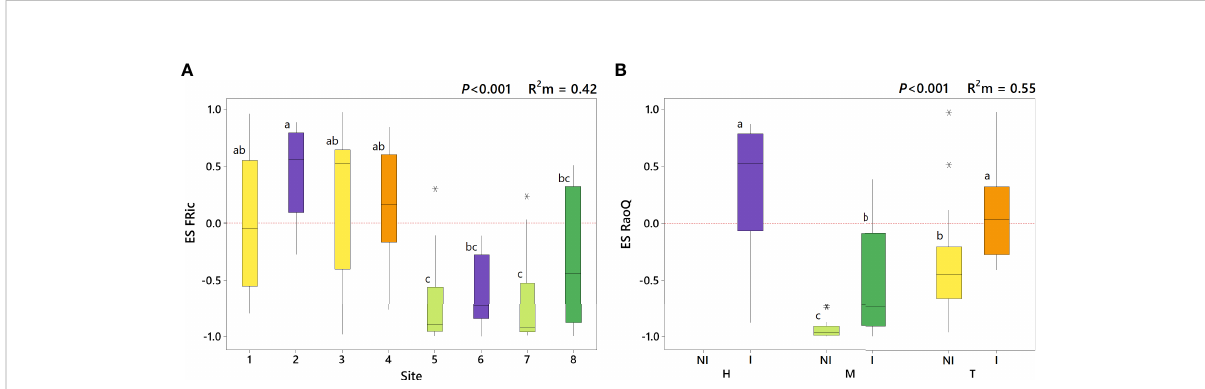
FIGURE 2 Effect size of FRic (ES FRic) depending on site (A) and effect size of RaoQ (ES RaoQ) depending on the interaction of weed management and irrigation (WM:I) (B) . Marginal R 2 ( R 2 m) provides the variance explained by the fi xed effects. Same letters on the boxes indicate no signi fi cant differences. H, herbicide; M, mowing; T, tillage; NI, non-irrigation; I, irrigation. Sites: 1, tilled inter-rows adjacent to herbicide-treated plots; 2, herbicide-treated rows adjacent to tilled plots; 3, tilled inter-rows adjacent to tilled plots; 4, tilled rows; 5, mown inter-rows adjacent